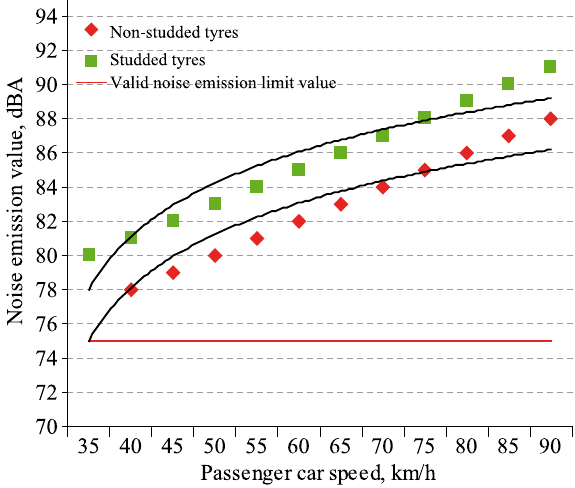
Fig. 7. Dependences of noise emission valueon speed and type of tyres of a passenger car by Kropp et al.